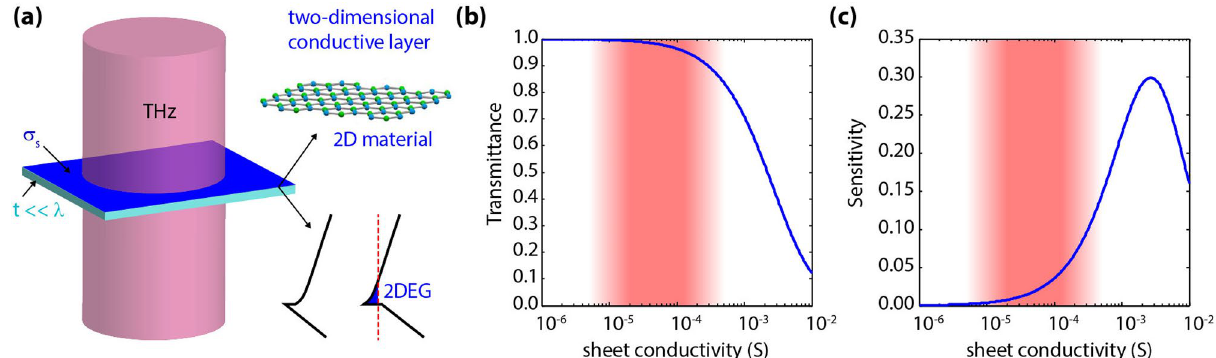
Figure 1. Terahertz transmission through a two-dimensional conductive layer (image created in Adobe Illustrator v25.0.1, https ://www.adobe .com/produ cts/illus trato r.html). ( a ) Illustration of the analyzed geometry, which consists of a conductive layer with sheet conductivity σ s on top of an optically thin substrate (t < < λ). ( b ) Calculated transmittance versus sheet conductivity. ( c ) Calculated transmission sensitivity versus sheet conductivity. Sensitivity peaks in the mS range, thus characterizing low-conductive layers (µS range) becomes